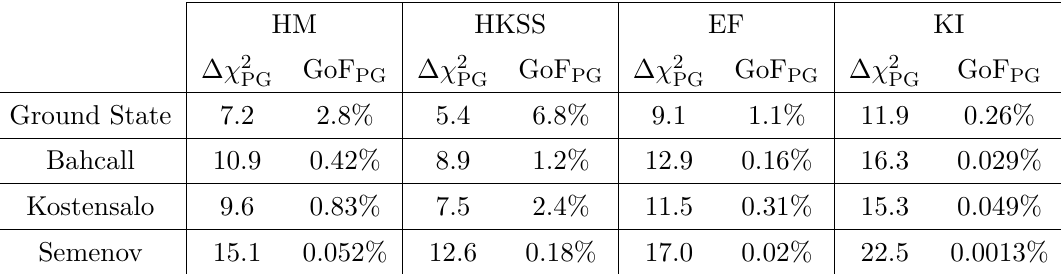
Table 2. χ 2 difference ∆ χ 2 of the parameter goodness of fit test [36] between the reactor rate PG data and the Gallium data corresponding to four different reactor flux predictions (HM, HKSS, EF, and KI) discussed in the text and four of the different Gallium detection cross sections in table 1. The values of the corresponding parameter goodness of fit GoF PG are calculated with two degrees of freedom corresponding to the two oscillation parameters sin 2 2 ϑ ee and ∆ m 2 which are common 41 in the reactor rates and Gallium data